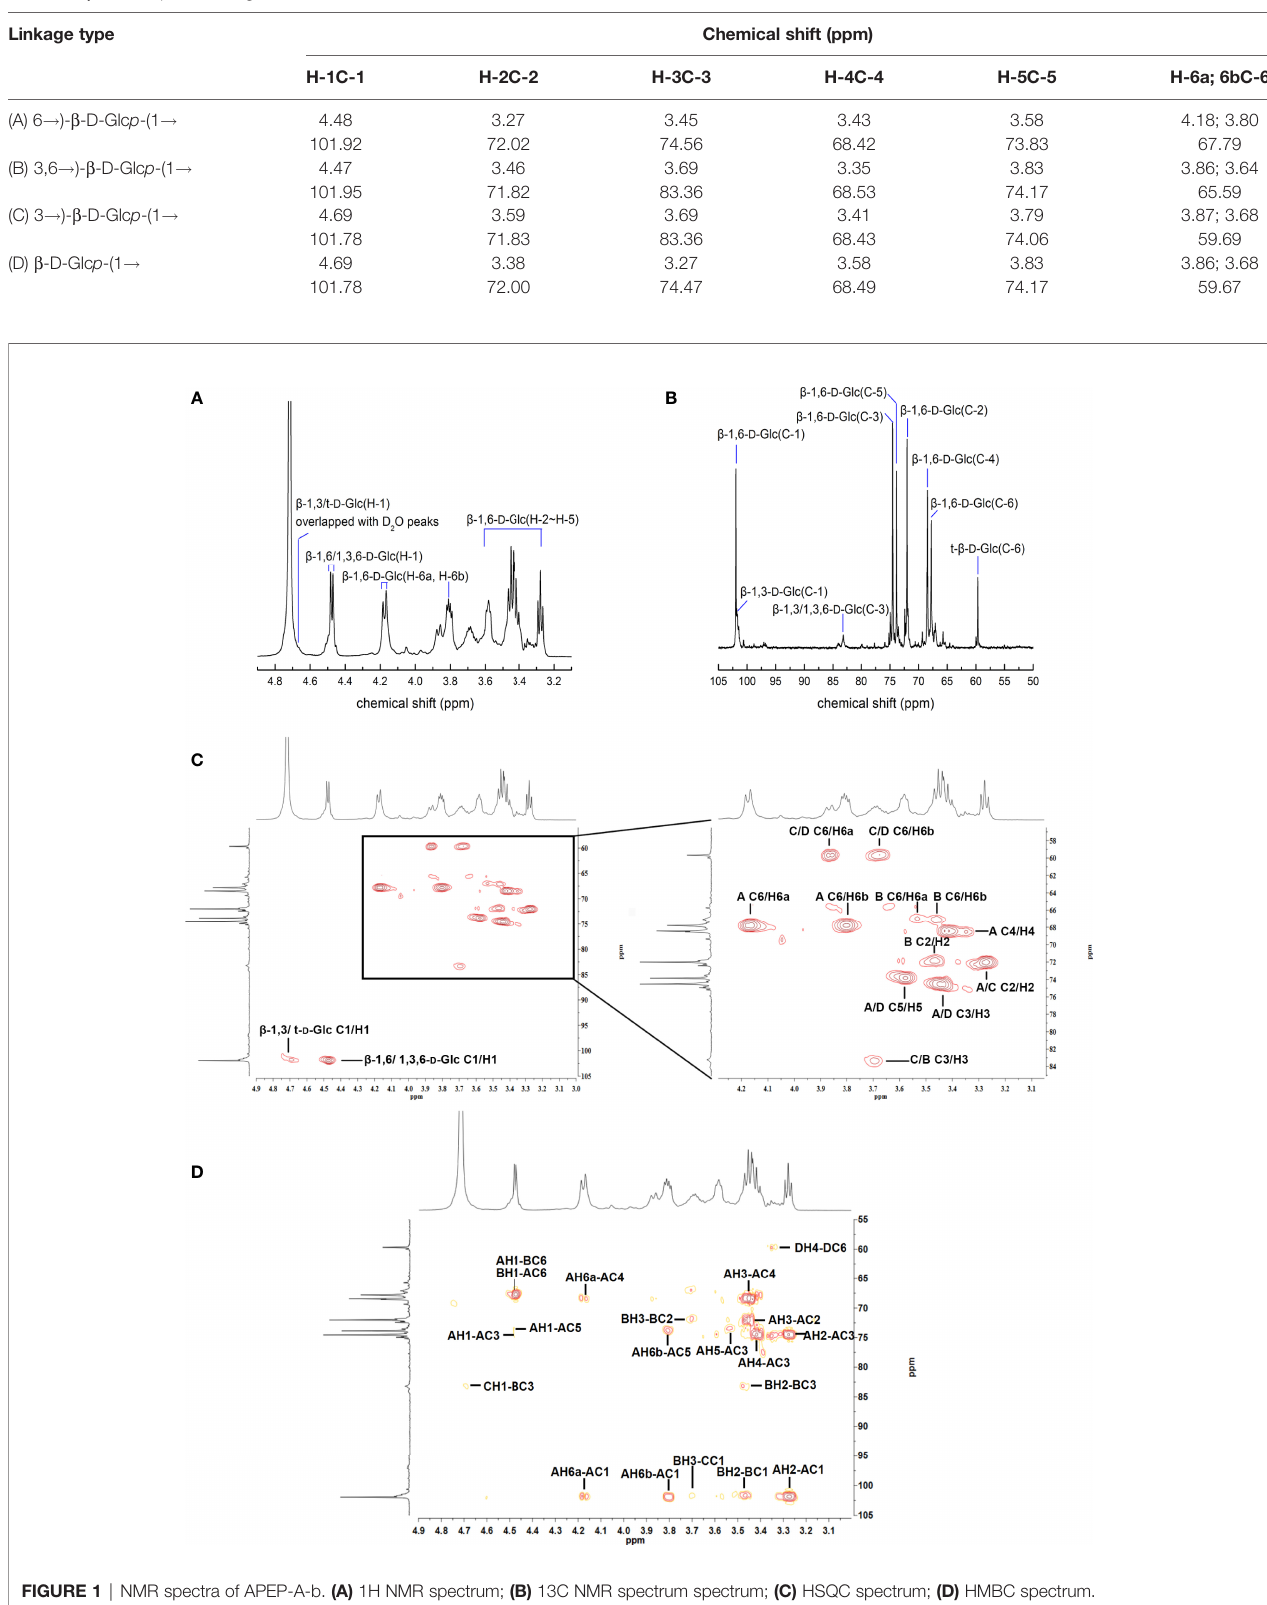
FIGURE 1 | NMR spectra of APEP-A-b. (A) 1H NMR spectrum; (B) 13C NMR spectrum spectrum; (C) HSQC spectrum; (D) HMBC spectrum.